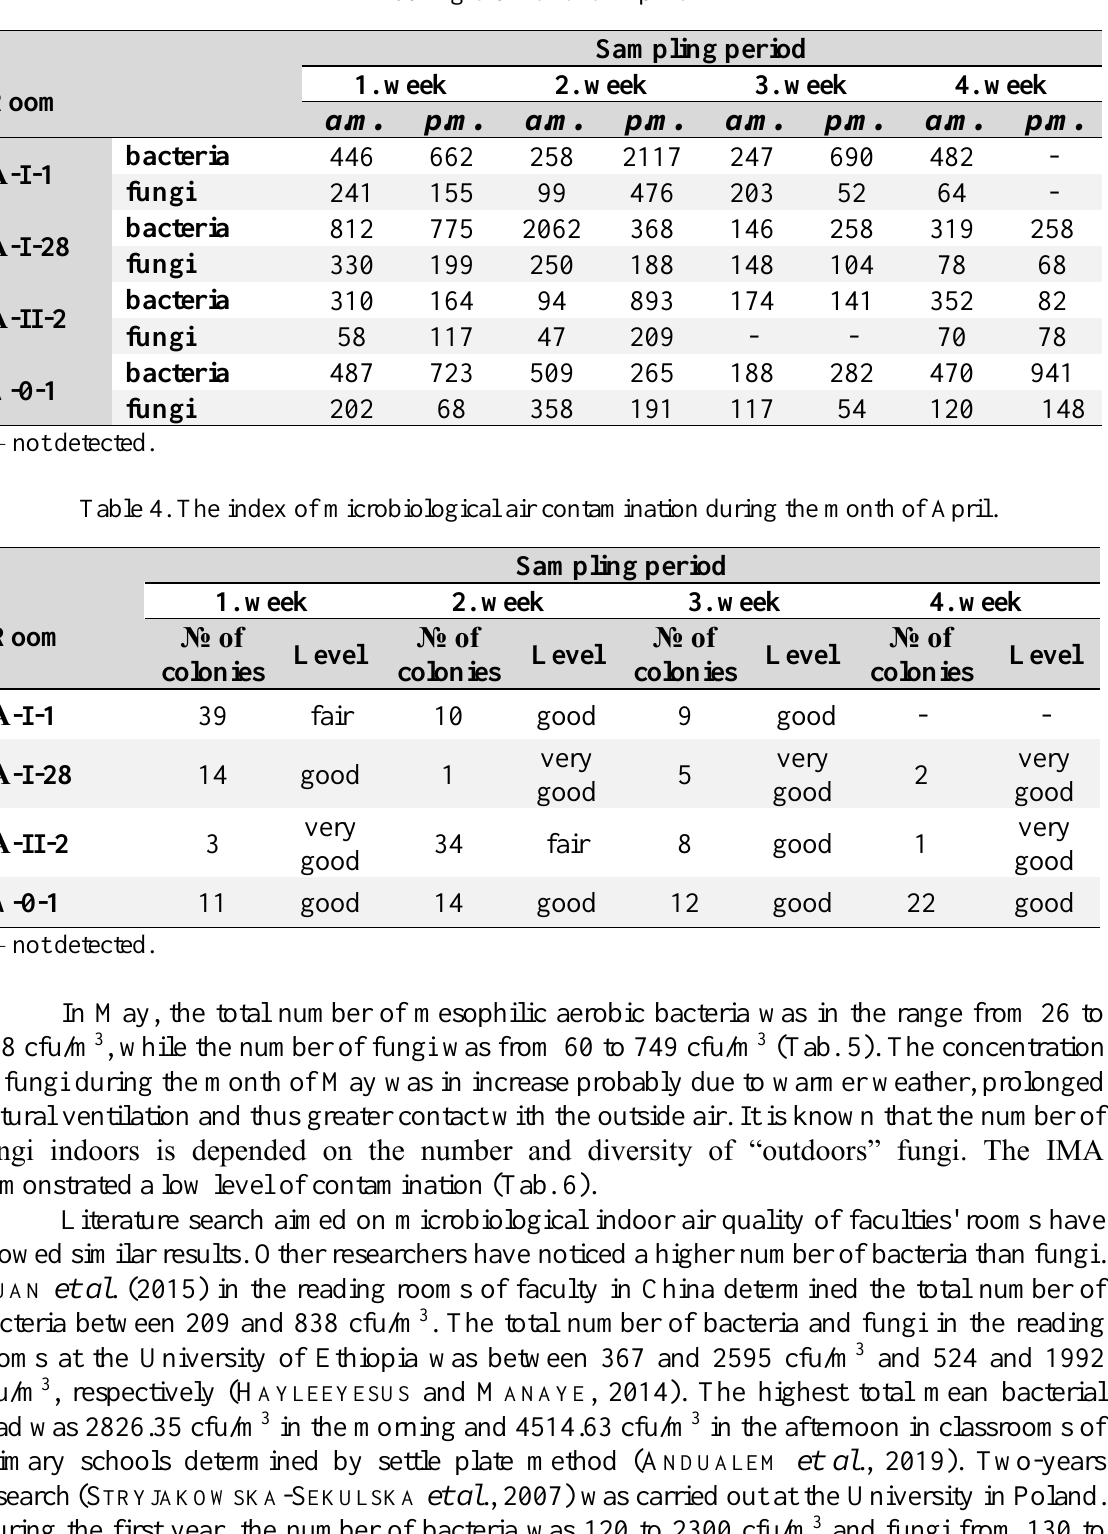
Table 3. The total number of bacteria/fungi (cfu/m 3 ) in indoor air in faculty's room during the month of April.